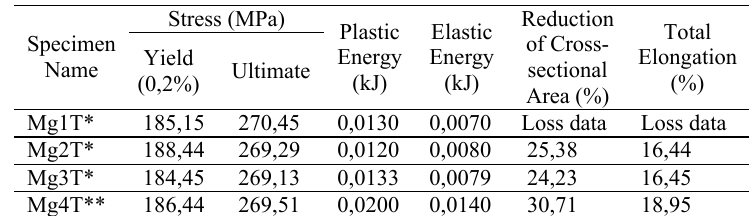
Table 2. Tensile test results